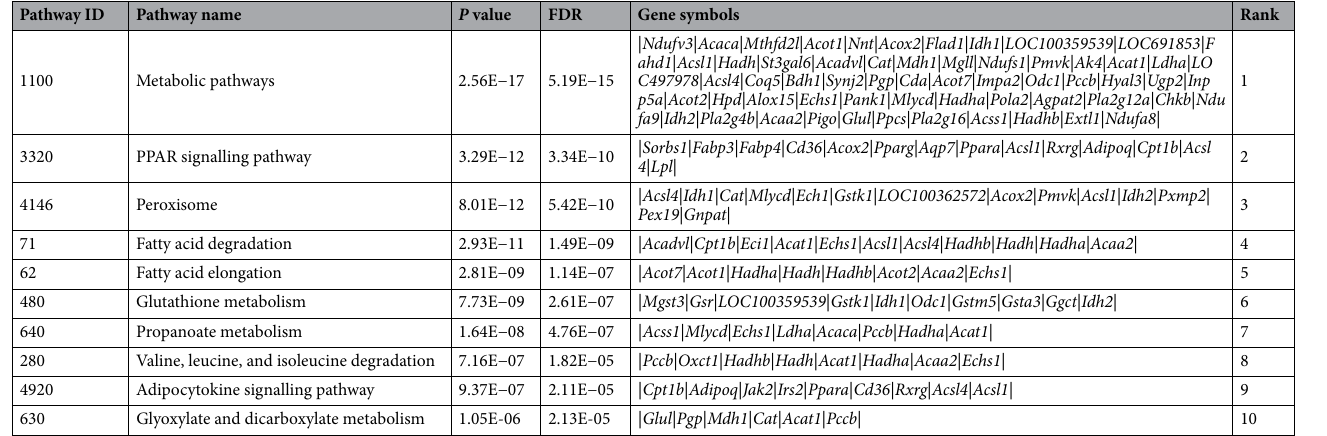
Table 3. Top 10 pathways with significant enrichment of differentially expressed genes (in order of increasing p